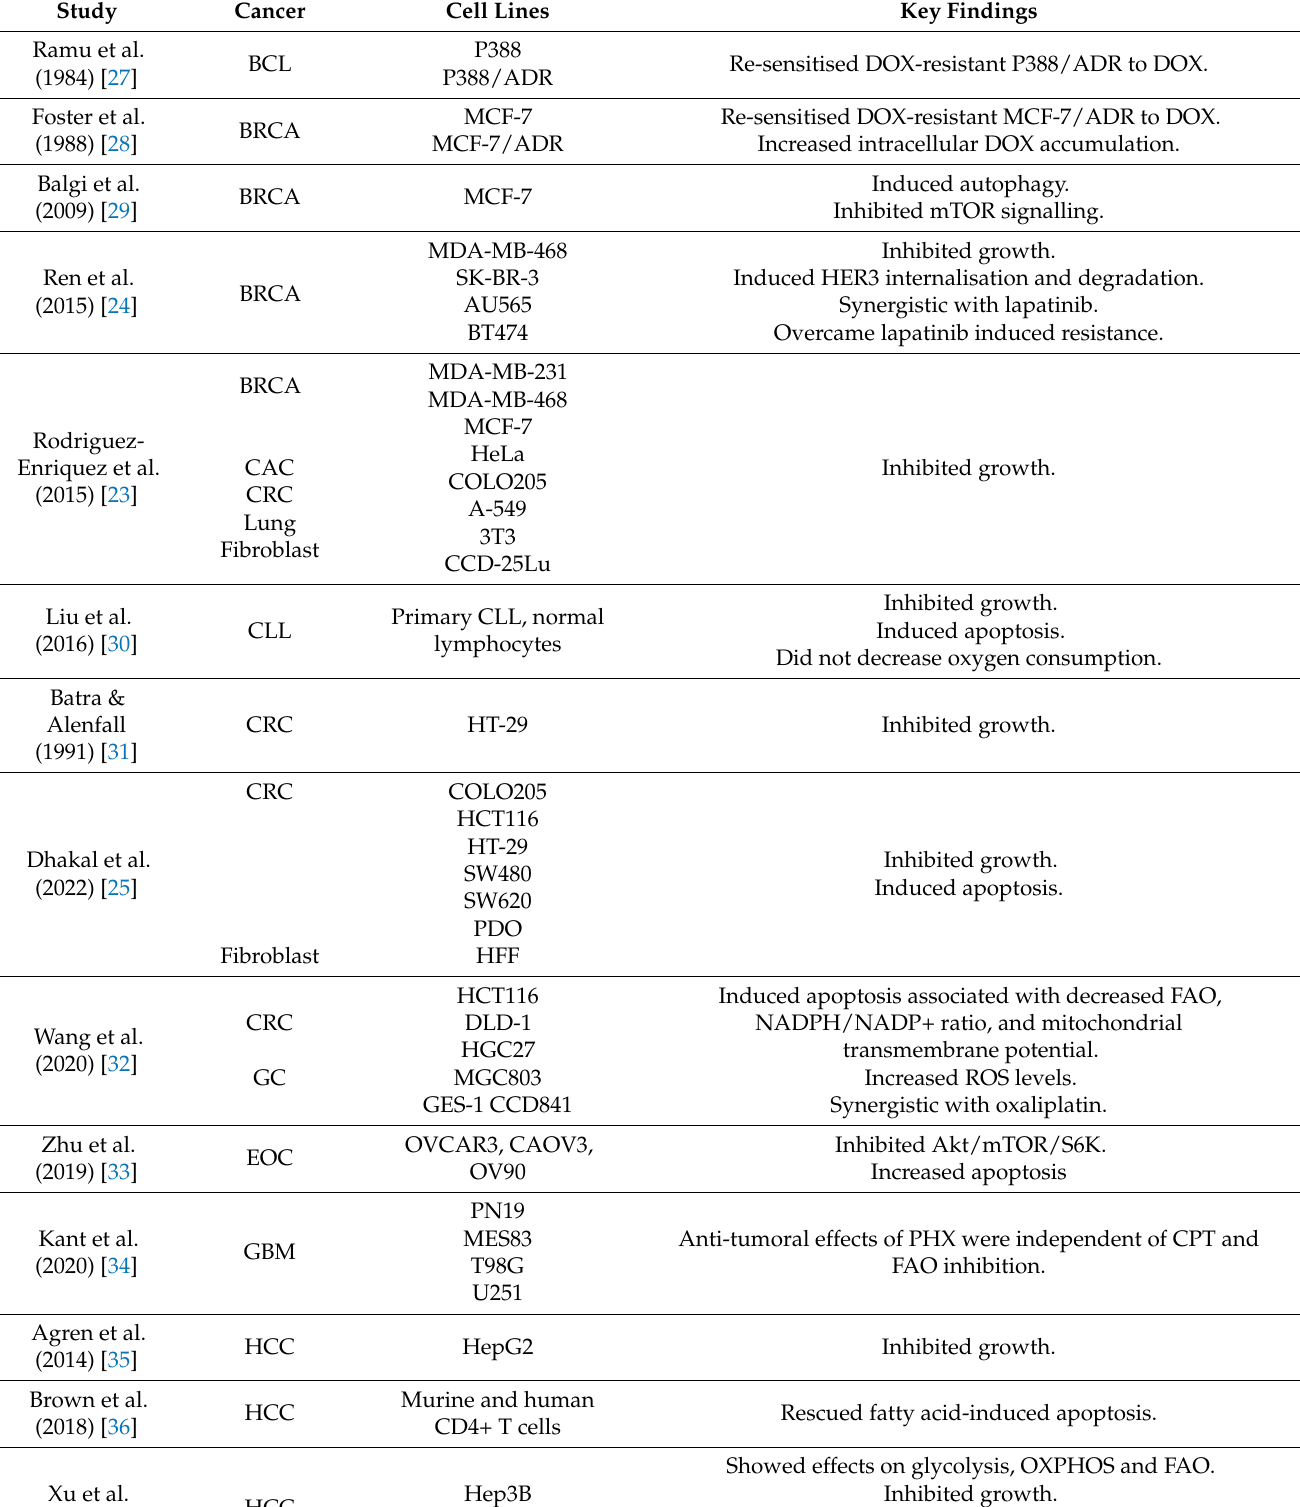
Table 1. Studies summarising the effects of perhexiline on various cancer cells in